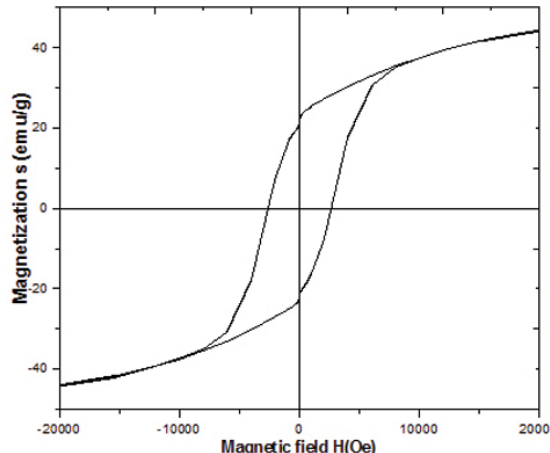
Figure 6. The magnetic hysteresis loops of magnetic porous poly- mer